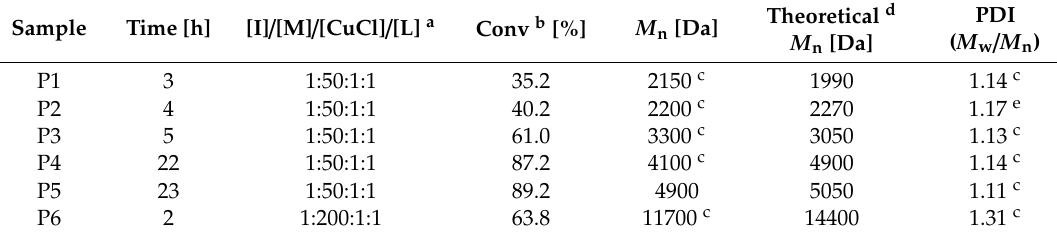
The molar ratios applied in the polymerization of N-isopropylacrylamid (NIPAM), monomer conversions, number-averaged molar masses ( M n ) and polydispersity indices from Size-Exclusion Chromatography (SEC) analyses. All polymerizations were carried out in isopropanol (NIPAM / isopropanol = 1:2 w / w ) at room